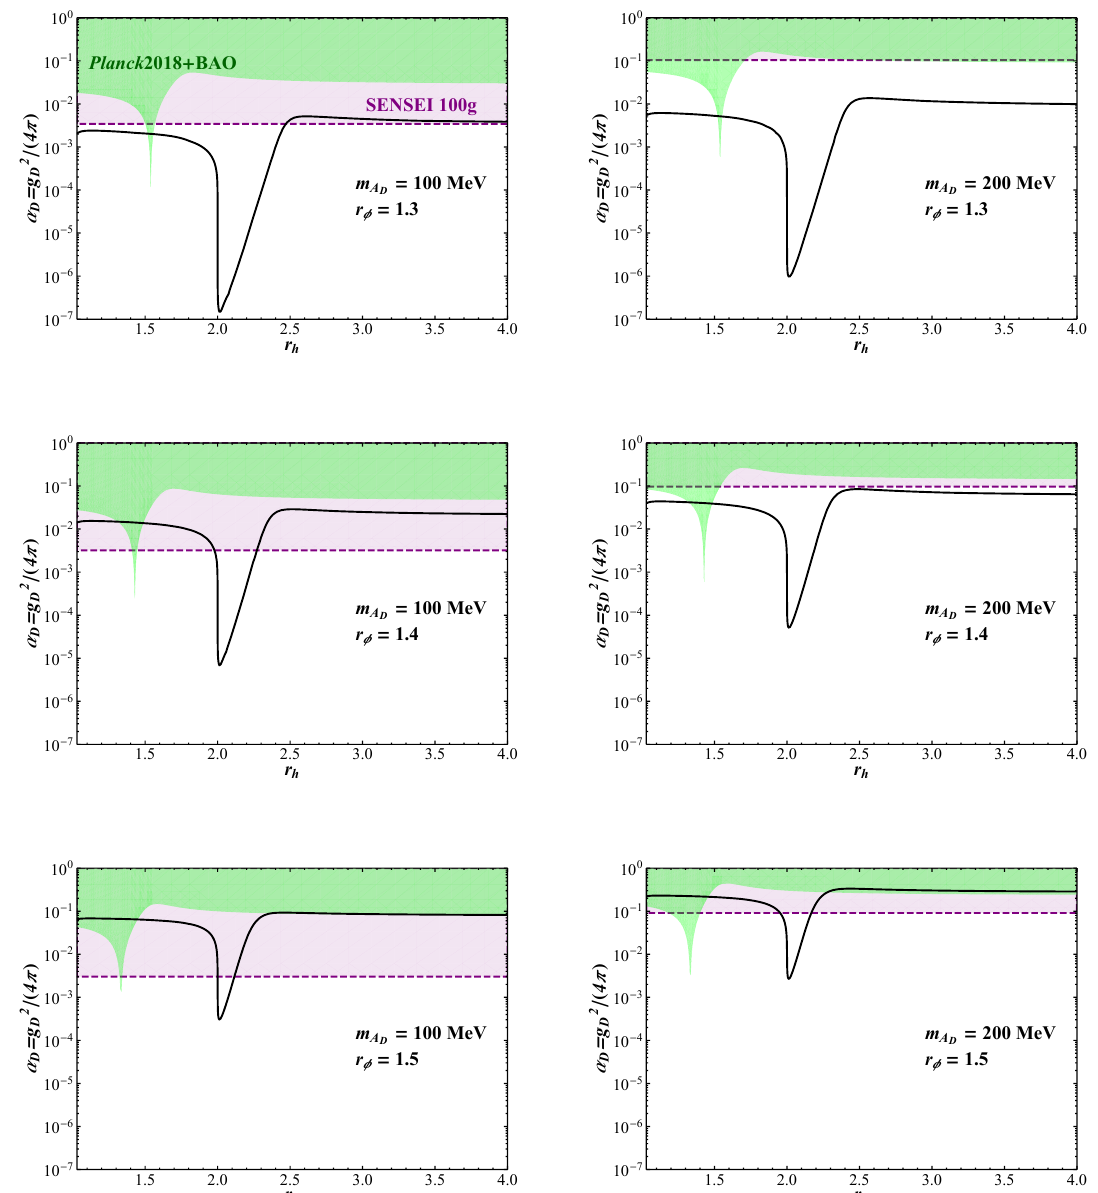
2 / (4 π ) that recreate the observed dark D − r h plane, where α D = g D 10 − 4 , for various choices of r φ and m A . Regions D × years of exposure [6] are depicted as a purple ·